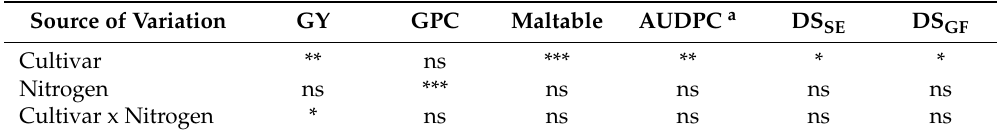
Table 1. ANOVA summary for grain yield (GY), grain protein content (GPC), maltable (% grains > 2.2 mm), AUDPC and disease severity during the onset of stem elongation (DS SE ) and grain filling (DS GF ) phases. Source of Variation